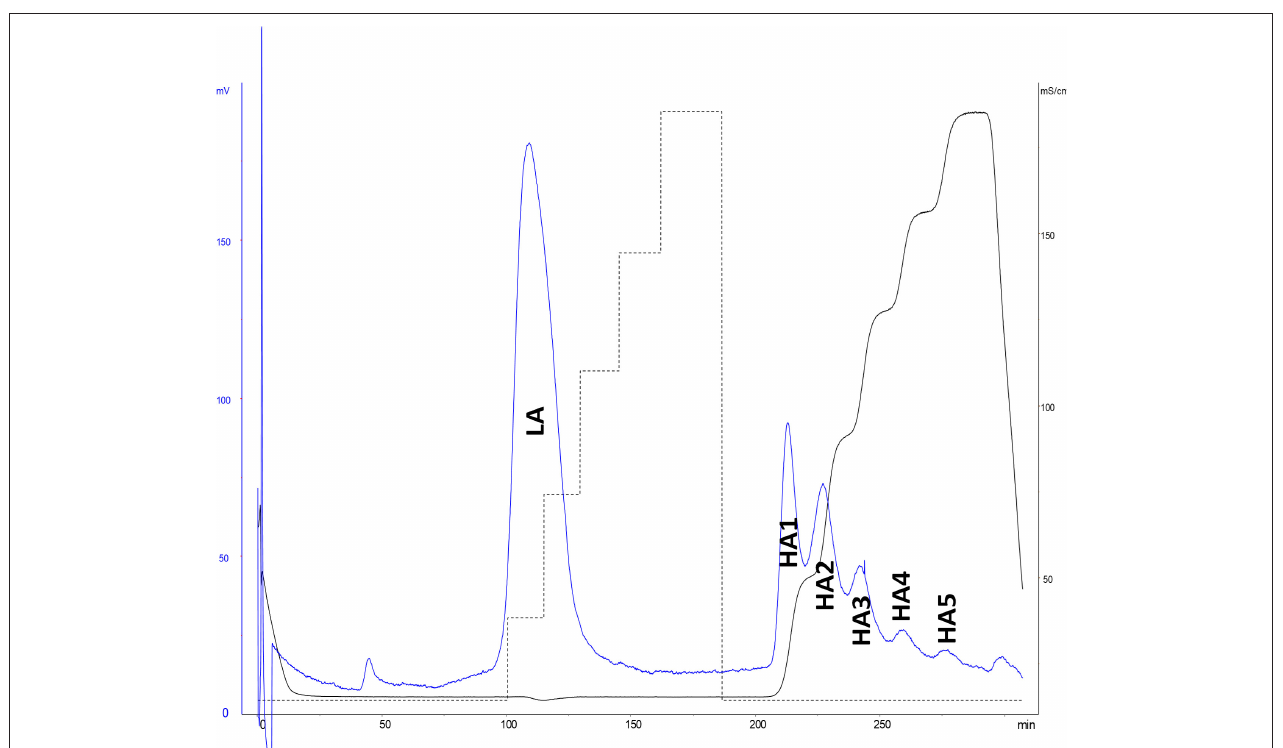
FIGURE 4 | ATIII affinity chromatography of bovine mucosal heparin (BMH). Detection by UV at 219nm and conductimetry.